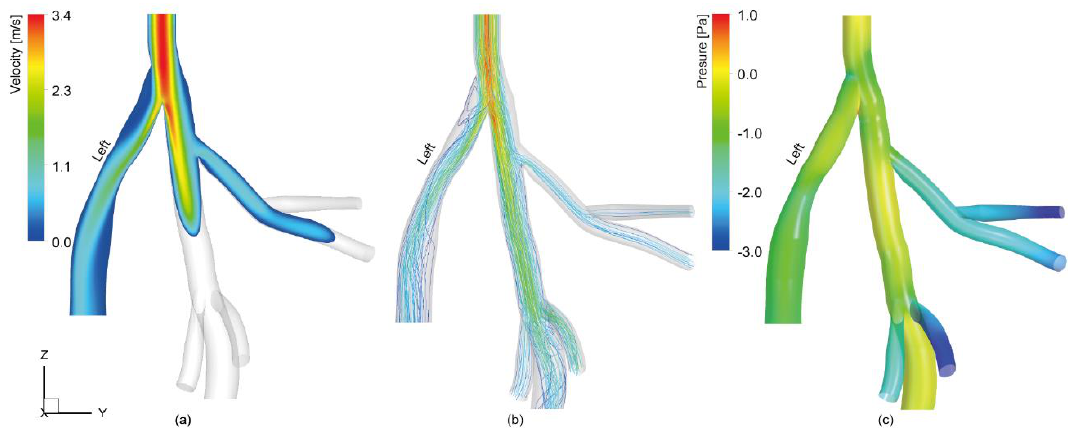
Figure 2. Airflow patterns in the rat lung airway: ( a ) Velocity magnitude contour in the center plane of the airway model; ( b ) airflow streamlines; and ( c ) surface pressure showing the pressure drop along the airway. Note, due to the irregular shape of the airway anatomy, velocity distributions in the lower half of the central airway were not presented in Figure 2a, but this can be viewed from velocity-colored streamlines in Figure 2b.